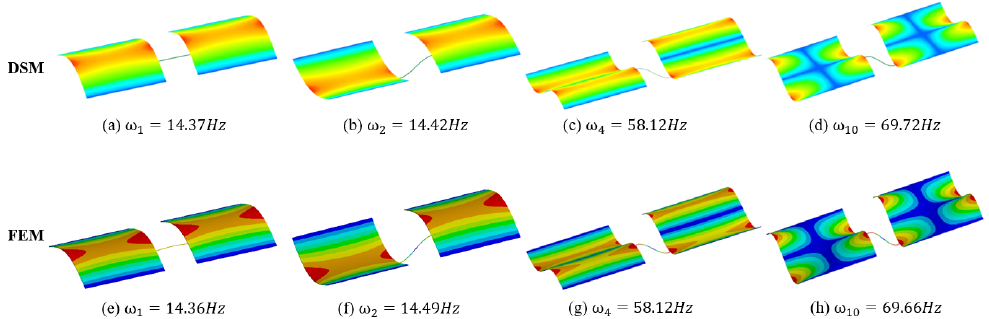
Figure 19. Comparison of the 1st, 2nd, 4th and 10th natural mode shapes of two plates coupled by a beam as shown in Figure 17b, the mode shapes are computed by both DSM and FE package